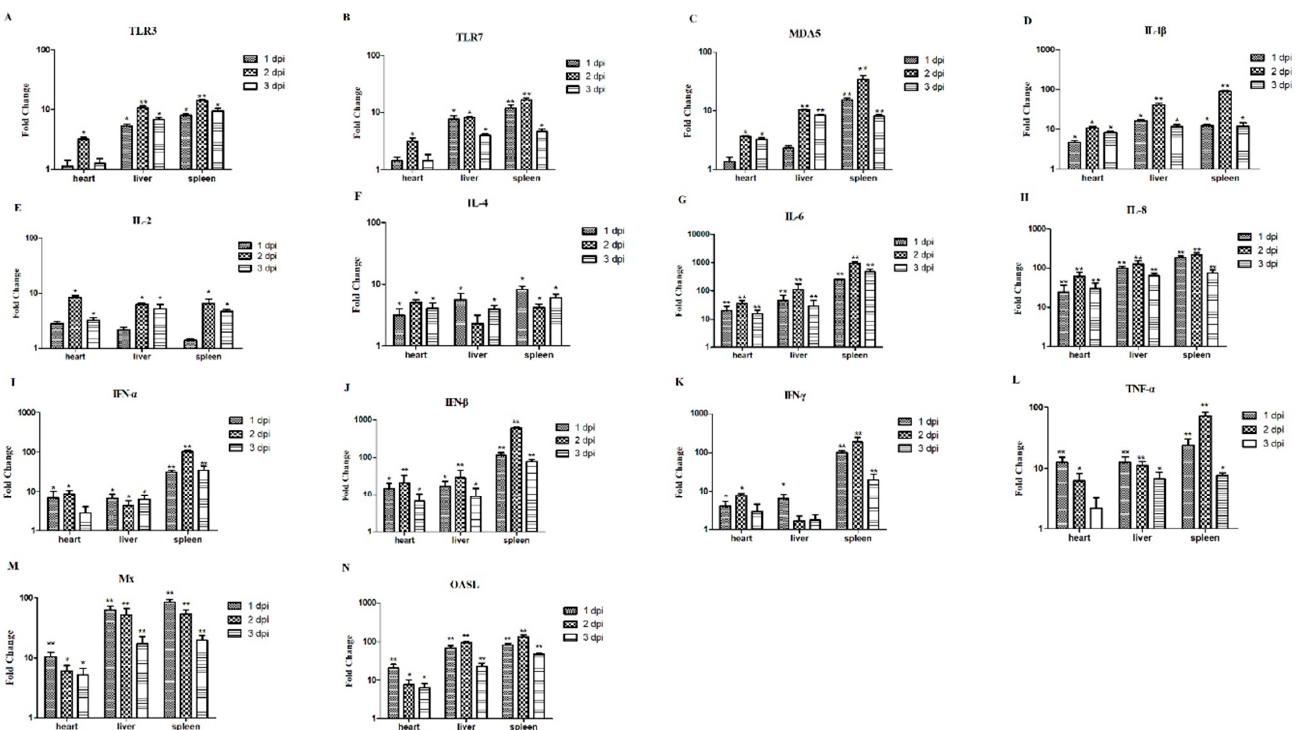
Figure 6. Expression profiles of immune-related genes in the hearts, livers, and spleens from IM-infected chickens. Tissue samples from chickens were collected at 1, 2, and 3 dpi. The inducible gene mRNA expression levels in the tissue samples were tested using real-time quantitative reverse transcription polymerase chain reaction (qRT-PCR) analysis. Relative expression levels were normalized to the β -actin gene and calculated using the 2 - △△ Ct method. The Y-axis represents the fold change in target gene expression in the experimental group versus that in the control group. Data are expressed as means ± standard deviations ( n = 3). ( A – N ) Expression levels of TLR3, TLR7, MDA5, IL-1 β , IL-2, IL-4, IL-6, IL-8, IFN- α , IFN- β , IFN- γ , TNF- α , Mx, and OASL in the hearts, livers, and spleens of infected chickens. Differences were analyzed using the Student’s t -test. * P < 0.05; ** P < 0.01. dpi, days post-infection.